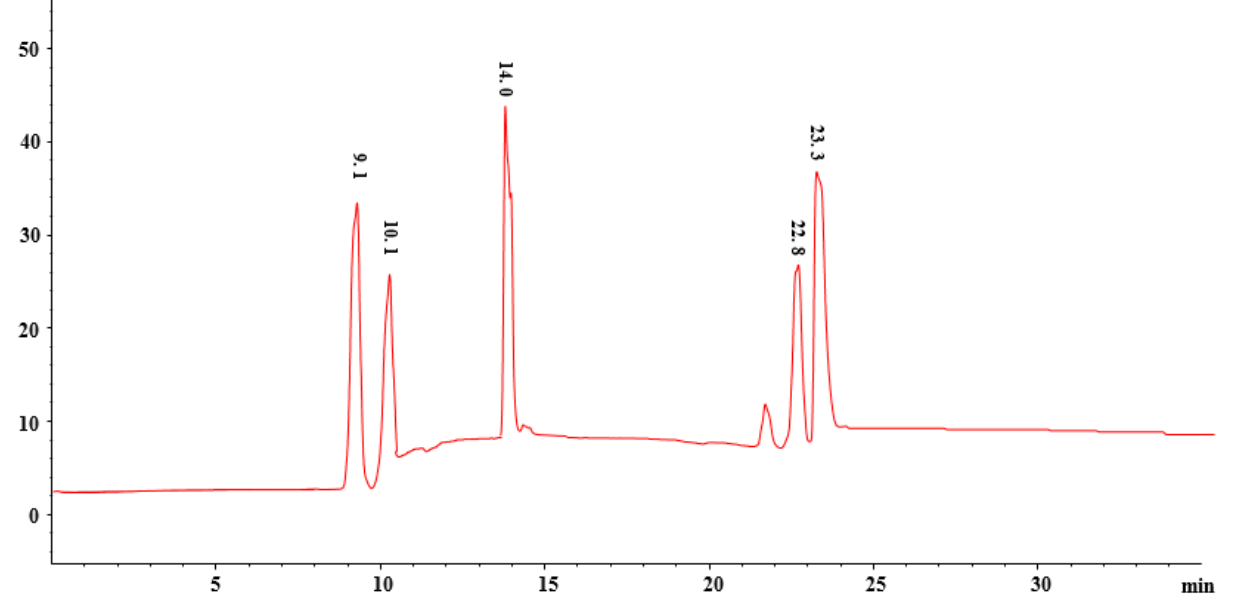
Figure 7. HPLC chromatogram of a mixture of external standards at 280 nm. (1) quinic acid, (2) peganine, (3) harmol, (4) harmaline, and (5) harmine.